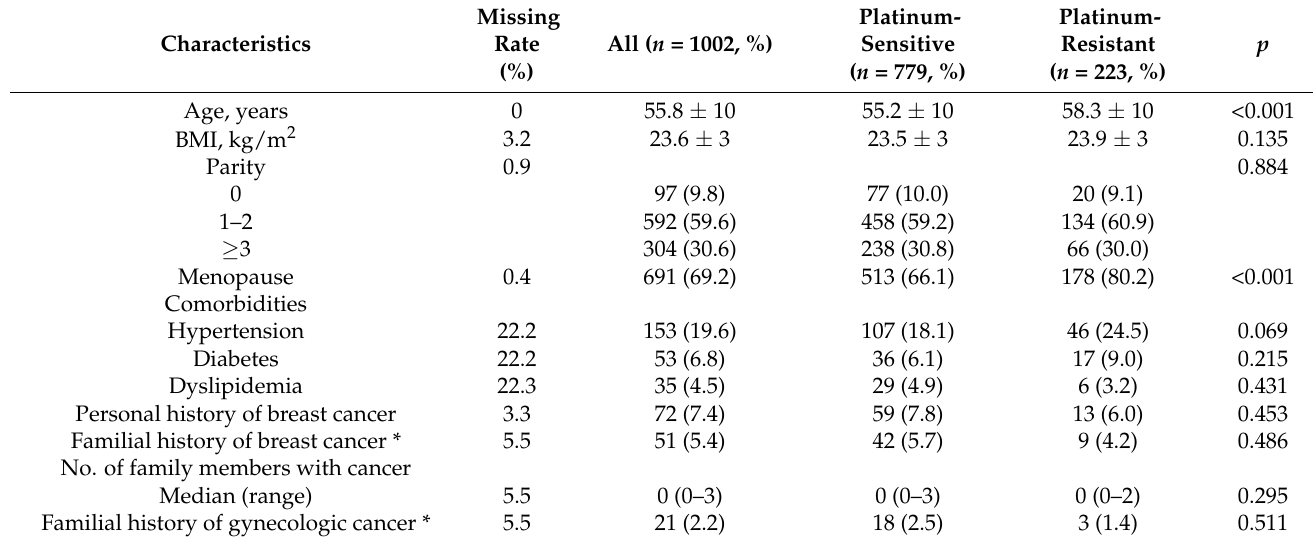
Figure 2. Survival outcomes of the study population. (Upper) All patients; (Lower) Comparisons between platinum-resistant and sensitive groups. ( A , C ) Progression-free survival; ( B , D ) Overall survival. Table 1. Patients’ clinicopathologic characteristics.